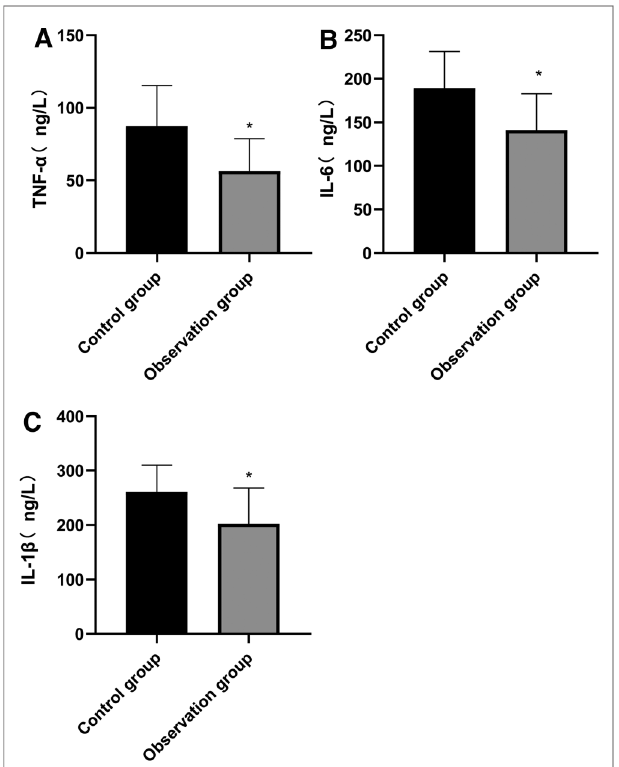
FIGURE 2 | Comparison of stress state index after surgery between two groups. Note: Compared with the control group, * p <0.05.